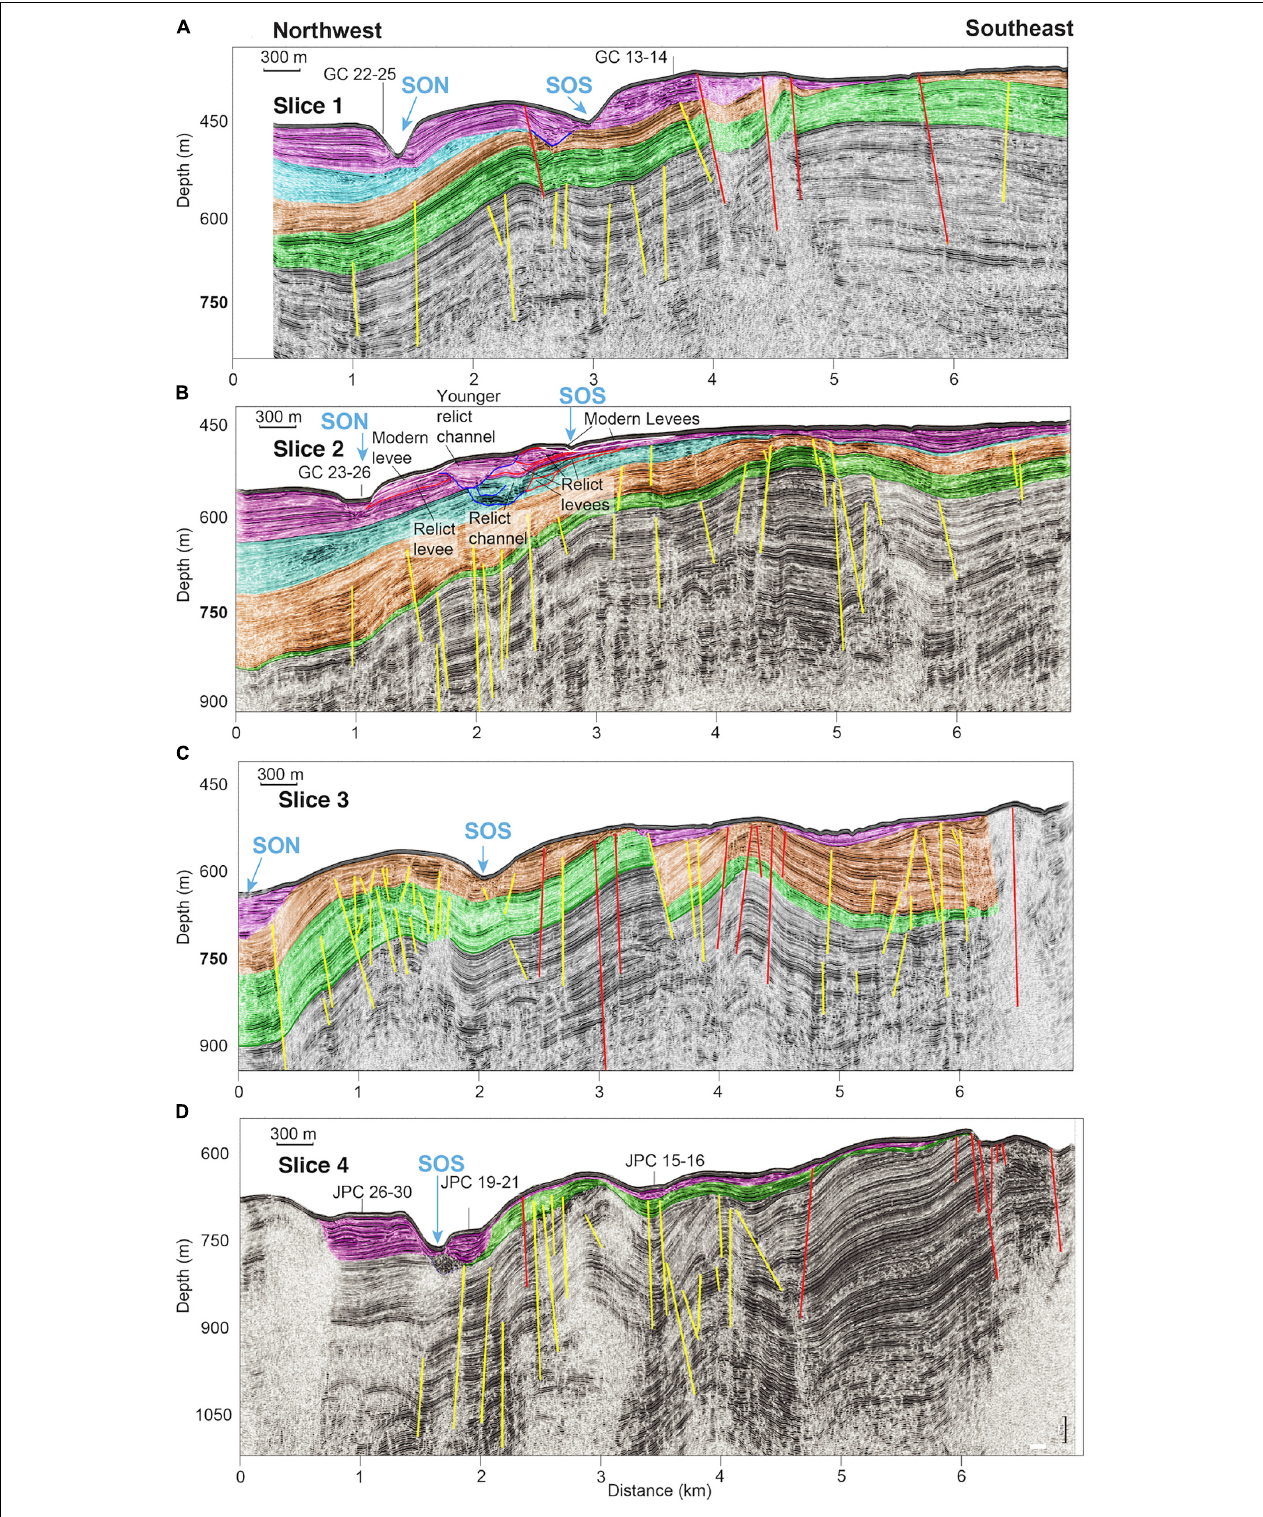
FIGURE 6 | Strike slices along the San Onofre margin reveal the internal architecture of the slope and channel elements. (A) Slice 1 and (B) slice 2 are located on the middle slope. (C) Slice 3 and (D) slice 4 are located on the lower slope. This anticline controls the location of the SON and SOS canyons ad well as the thickness of Pink, Blue, Orange, and Green units. The shallowest (easternmost) slice is at the top and the deepest slice (westernmost) is at the bottom. Sediment cores are projected onto seismic slices. Locations of lines are shown in Figure 1 . Vertical Exaggeration = 5.1. For uninterpreted seismic profiles, see Supplementary Figure S3